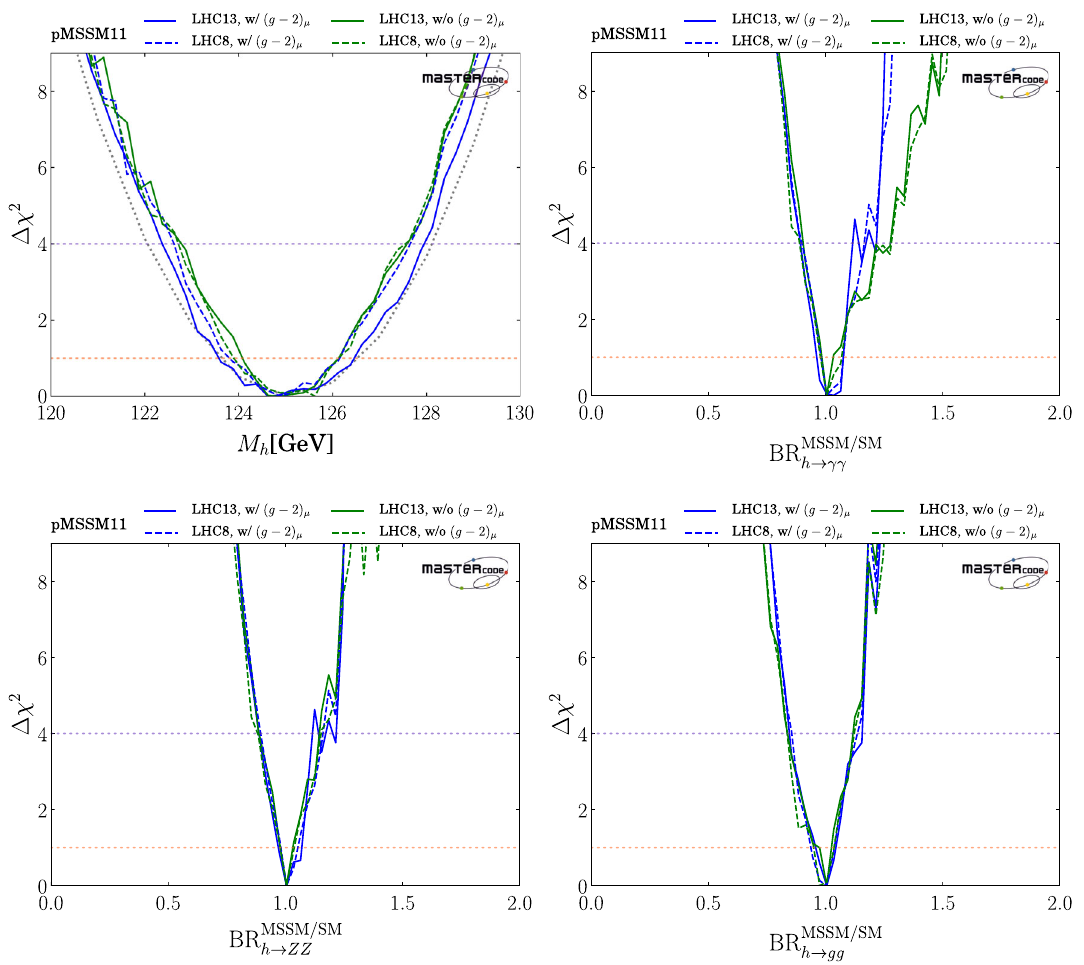
Fig. 16 One-dimensional profile likelihood plots for M h (upper left panel), for the h → γγ branching ratio in the pMSSM11 relative to that in the SM with (upper right panel), for the h → Z Z ∗ branching ratio (lower left panel) and for the h → gg branching ratio (lower